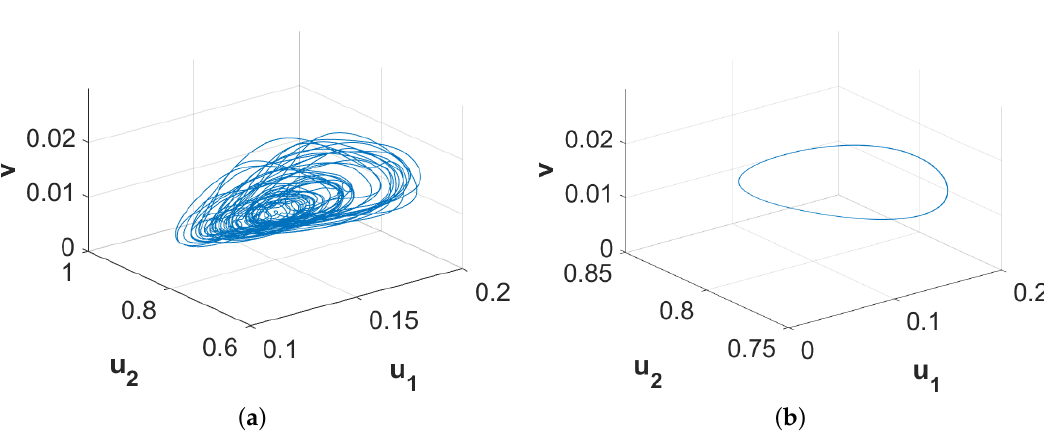
Figure 9. Phase diagrams of spatial average densities of the associated three species corresponding to ( a ) Figure 8a, ( b ) Figure